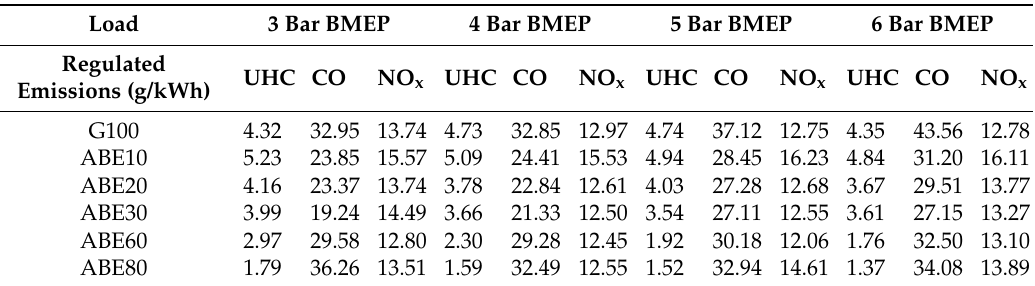
Table 8. Regulated emissions of test fuels at ϕ = 1 under different engine